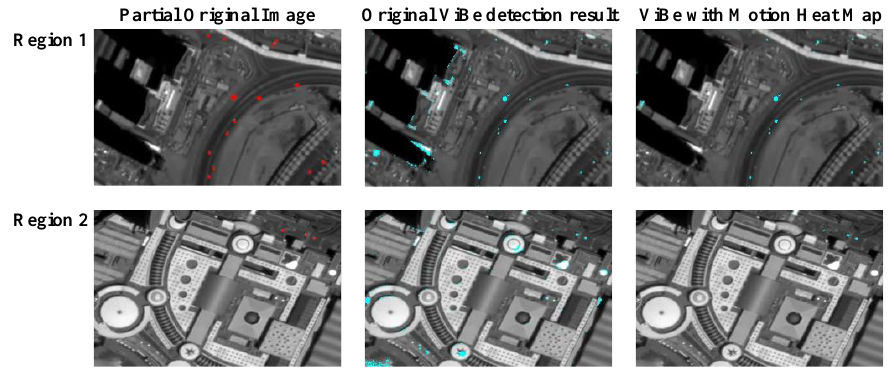
Figure 9. Comparision result of original ViBe(Visual Background extractor) detection and ViBe with motion heat map. In every row of the figure, from left to right: the original image with manually marked ground truth in red, the original ViBe detection result, and ViBe detection result with motion heat map.